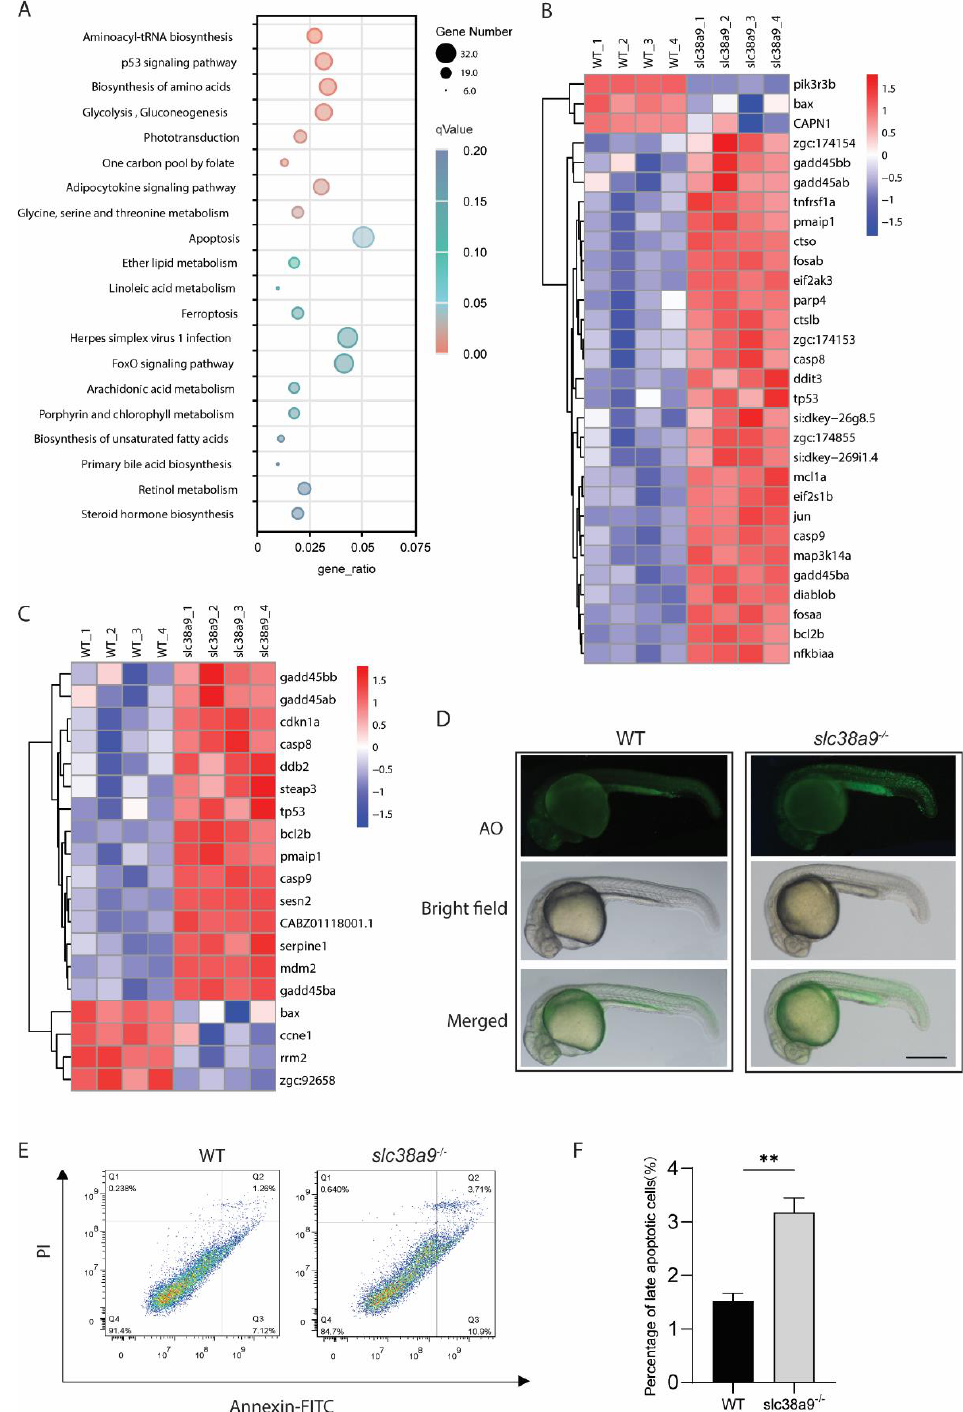
Figure 4. Slc38a9 Deficiency induces apoptosis and alters multiple metabolic pathways. ( A ) Kyoto Encyclopedia of Genes and Genomes (KEGG) enrichment analysis of differentially expressed genes. The X-axis indicates gene ratio, the size of dots represents the number of genes in the pathway, and the color indicates the size of the qValue. ( B ) Heatmaps of transcripts in apoptosis enrichment. ( C ) Heatmaps of transcripts in p53 signaling pathway enrichment. ( D ) Larvae were stained with AO to visualize apoptotic cells identified as green punctate dots. Scale bar = 500 µ m. ( E ) Annexin/PI apoptosis analysis in WT and slc38a9 mutant zebrafish embryos (3 dpf). ( F ) The percentage of late apop- tosis cells in WT and slc38a9 mutant zebrafish embryos. Data shown are mean ± SEM, n = 3. ** p < 0.01.